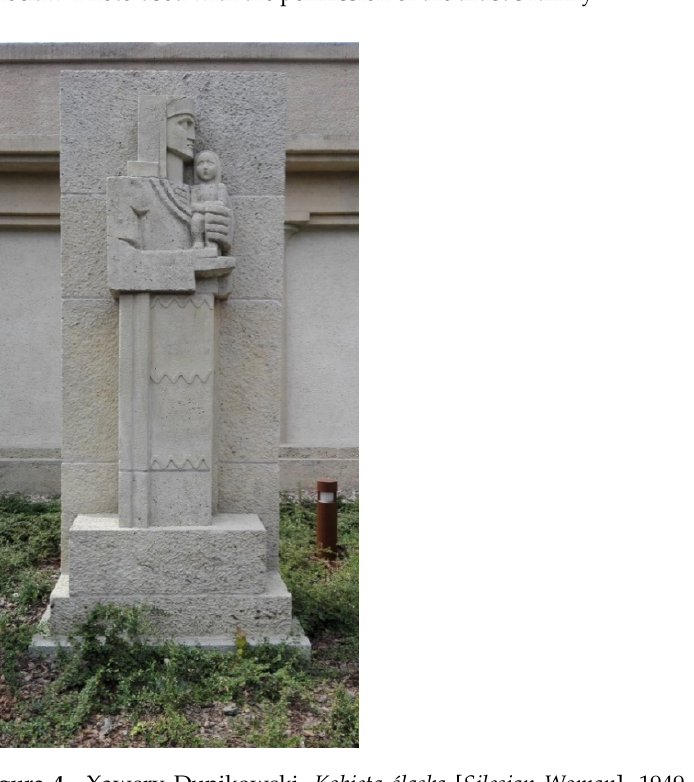
Figure 3. Leon Podsiadły, Figury medytacyjne. Poranek [ Meditating Figures. Morning ], 1978, white concrete with aggregate, Osobowicki Cemetery in Wrocław. After: Ośrodek Dokumentacji Sztuki Akademii Sztuk Pięknych im. Eugeniusza Gepperta [the E. Geppert Academy of Art and Design] in Wrocław. Photo used with the permission of the artist’s family.